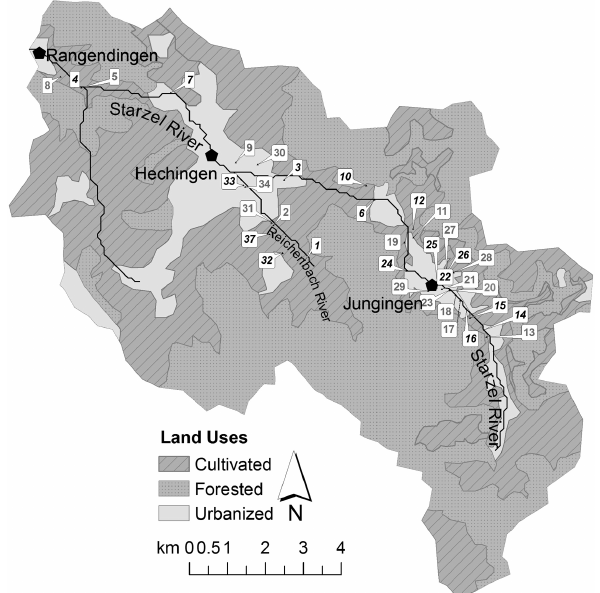
Fig. 2. Land use map of the Starzel catchment. Numbers refer to the surveyed cross sections during the intensive post event cam- paign; the 17 sections considered for the study are marked in